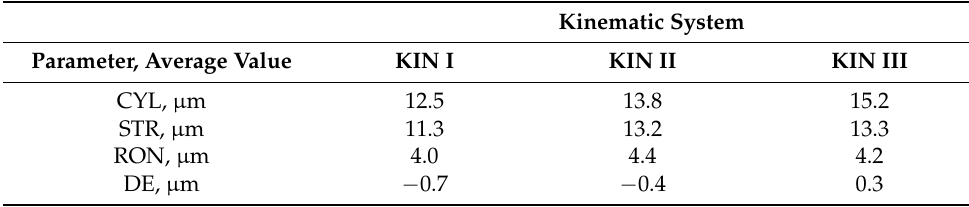
Table 10. Average values of the output parameters for each kinematic system